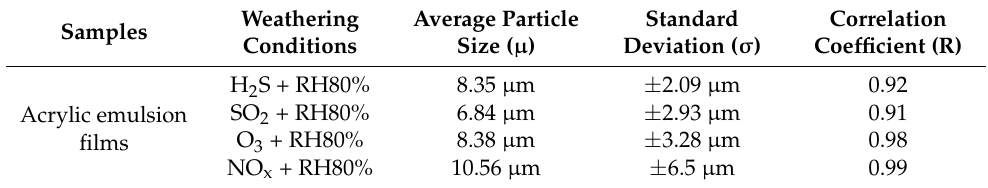
Table 2. Parameters derived from the particle size histogram corresponding to Gaussian